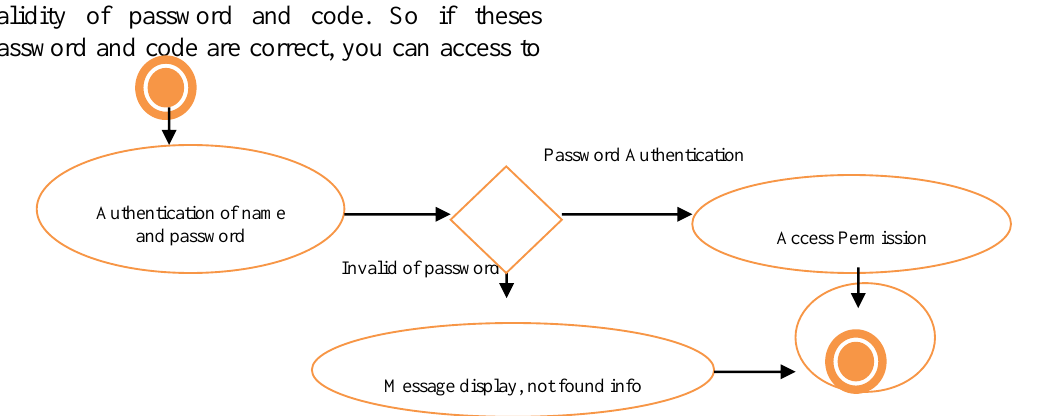
Figure 13. Capability model of user License agent.